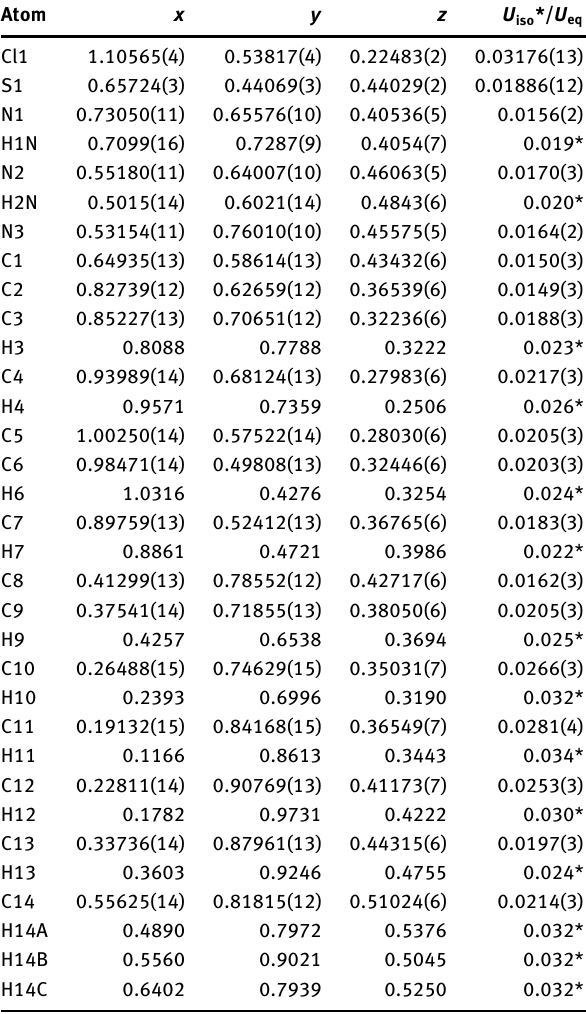
Table 2: Fractional atomic coordinates and isotropic or equivalent isotropic displacement parameters (Å 2